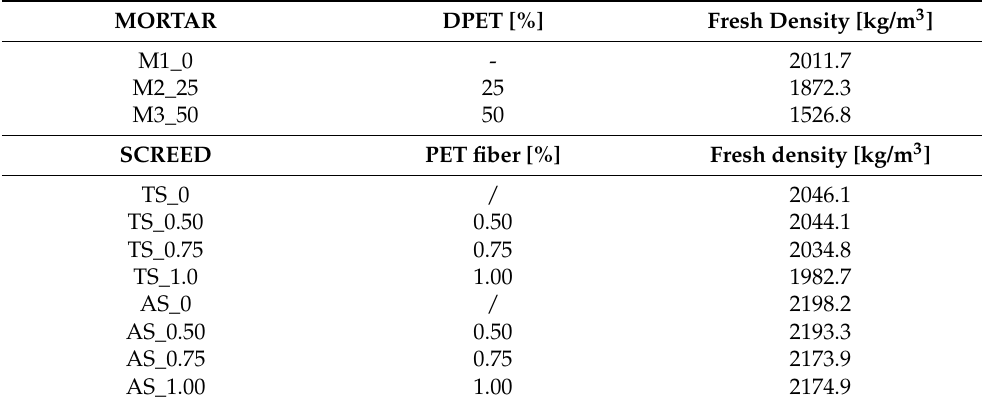
Table 3. Fresh density values of the tested mortars and